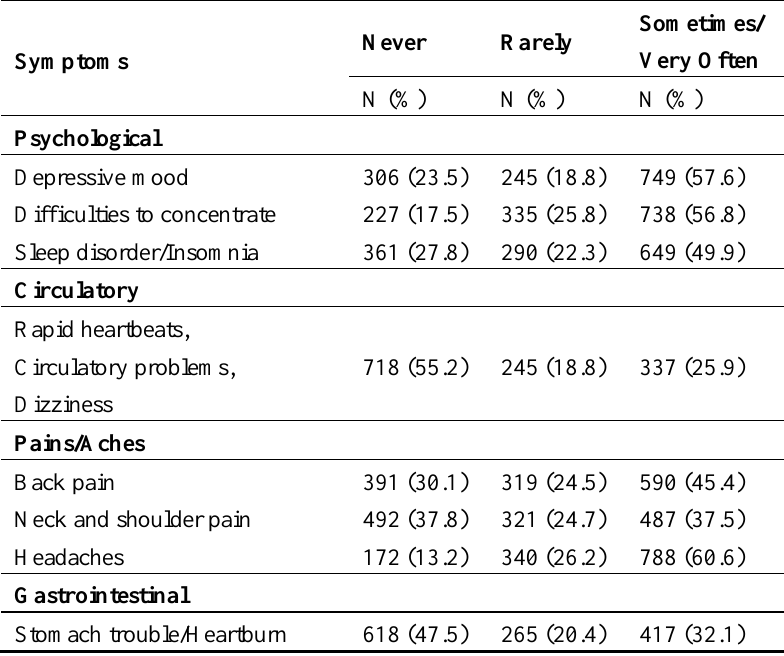
Table 2. Prevalence of symptoms during last 12